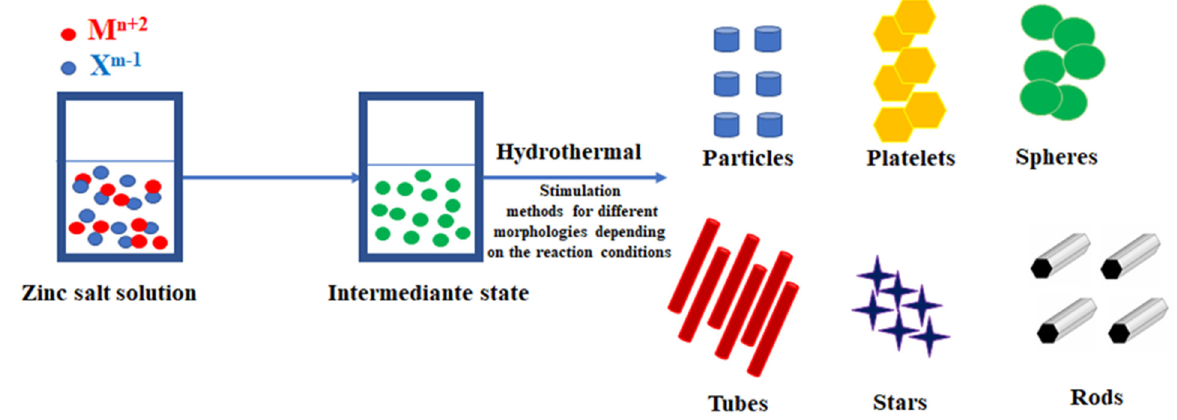
Figure 7. Schematic illustration for the morphology engineering of zinc oxide nanoparticles.